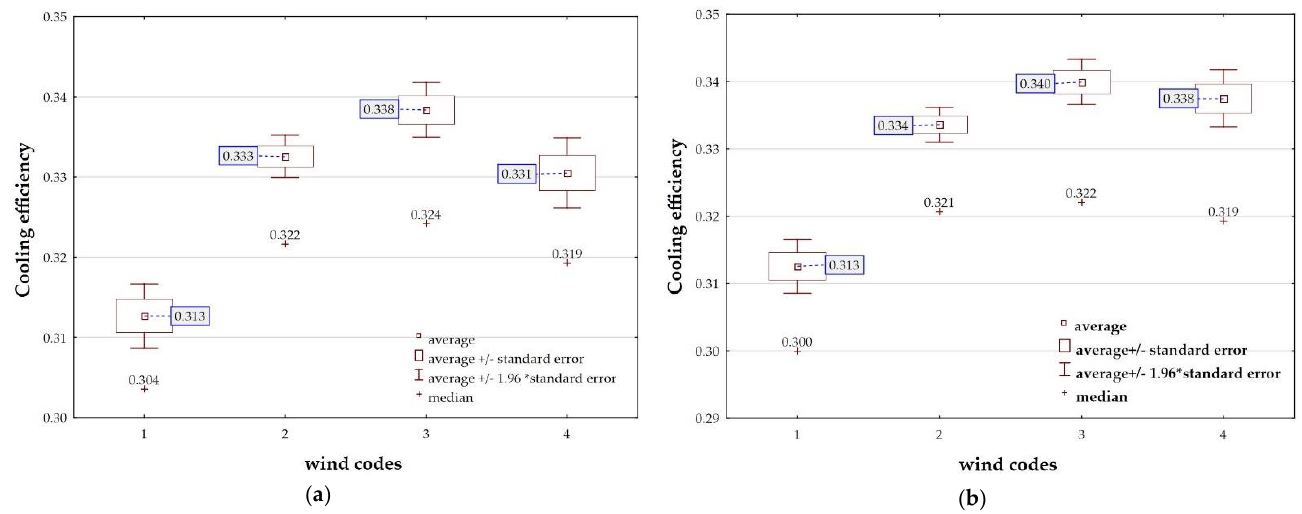
Figure 10. The effect of wind velocity on cooling efficiency 𝜀 of ( a ) power unit 5; ( b ) power unit 6. Source: own elaboration (Statistica software). Table 4. Test results for the variable: water loss stream for units 5+6/Power generation B 5 + B 6